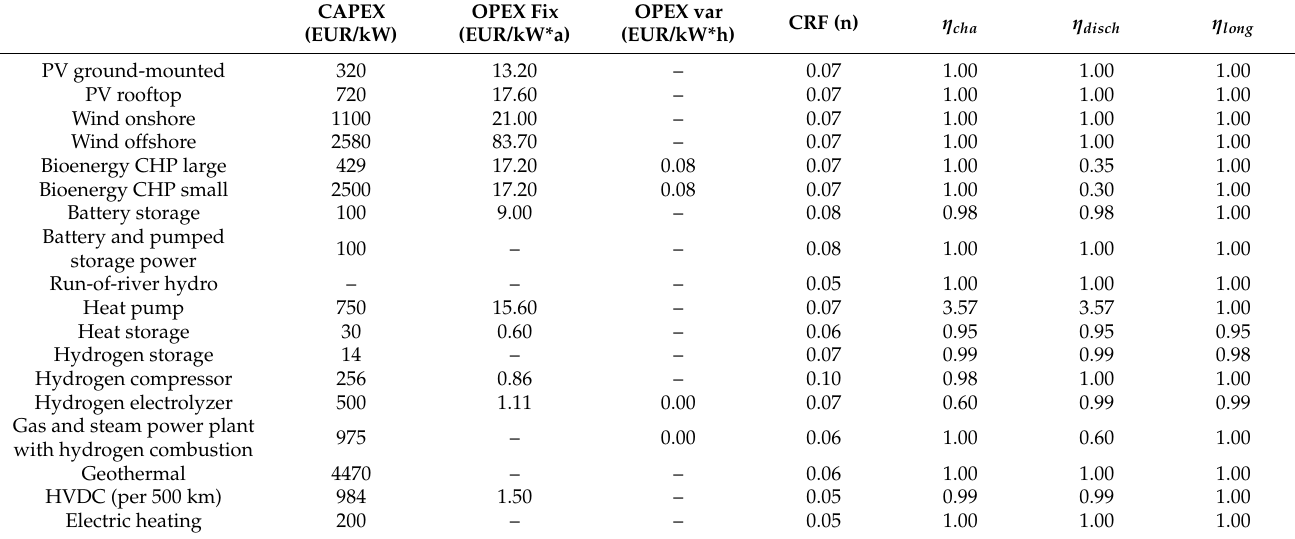
Table A1. Capital expenditure (CAPEX), variable, and fixed operational expenditure (OPEX) of conversion technologies, and charging, discharging, and long-term degrees of efficiency ( η